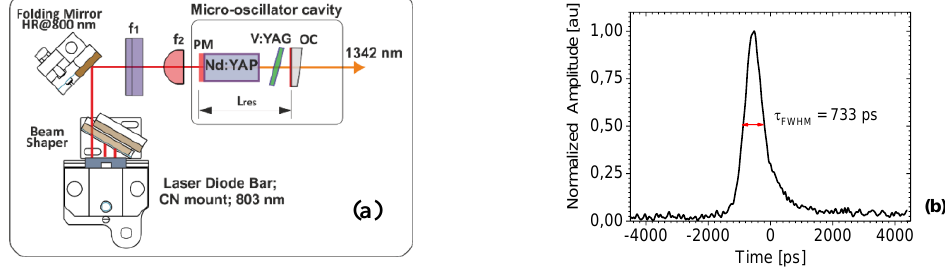
Fig. 1. Layout of the laser system (a) and oscilloscope trace of the Q-switched pulse